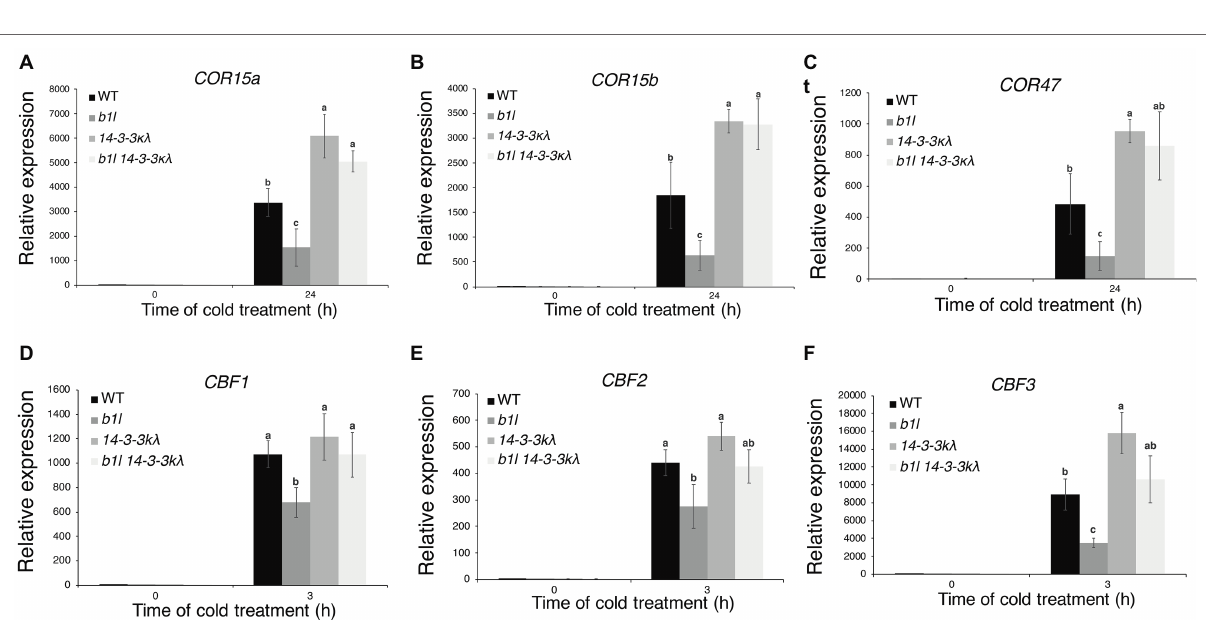
FIGURE 6 | The expression of CBF s and COR genes in 14-3-3k λ and b1l 14-3-3k λ under cold treatment. The expression of the CBF target genes COR15a , COR15b , and COR47 (A–C) and CBF genes (D–F) in wild type, b1l , 14-3-3k λ , and b1l 14-3-3k λ seedlings was determined by qRT-PCR analyses. The data are shown as means of three independent biological replicates ± SD. Significant differences ( p < 0.05) are indicated by different lowercase letters.